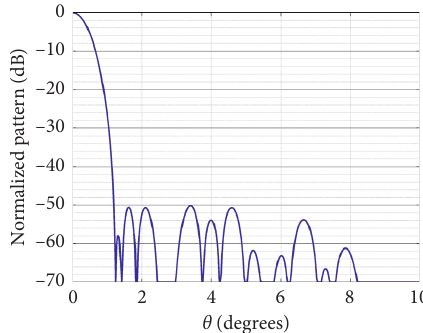
Figure 15: The two-way array pattern for N